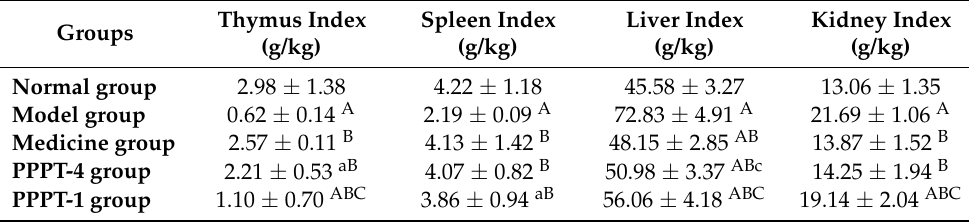
Table 4. Effect of PPPT on organ index in type II diabetic mice.